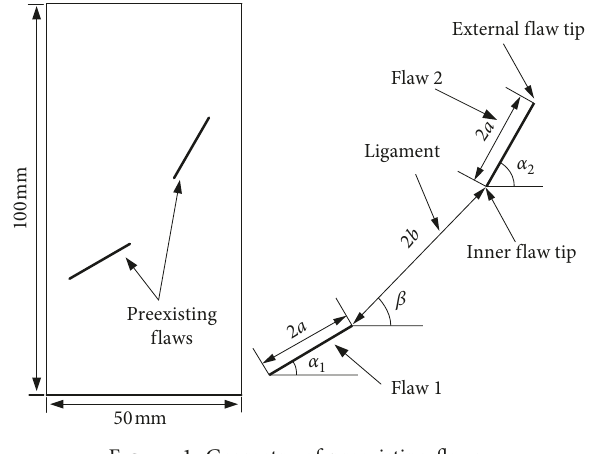
Figure 1: Geometry of preexisting Table 1: Flaw geometries of two unparallel flaws.